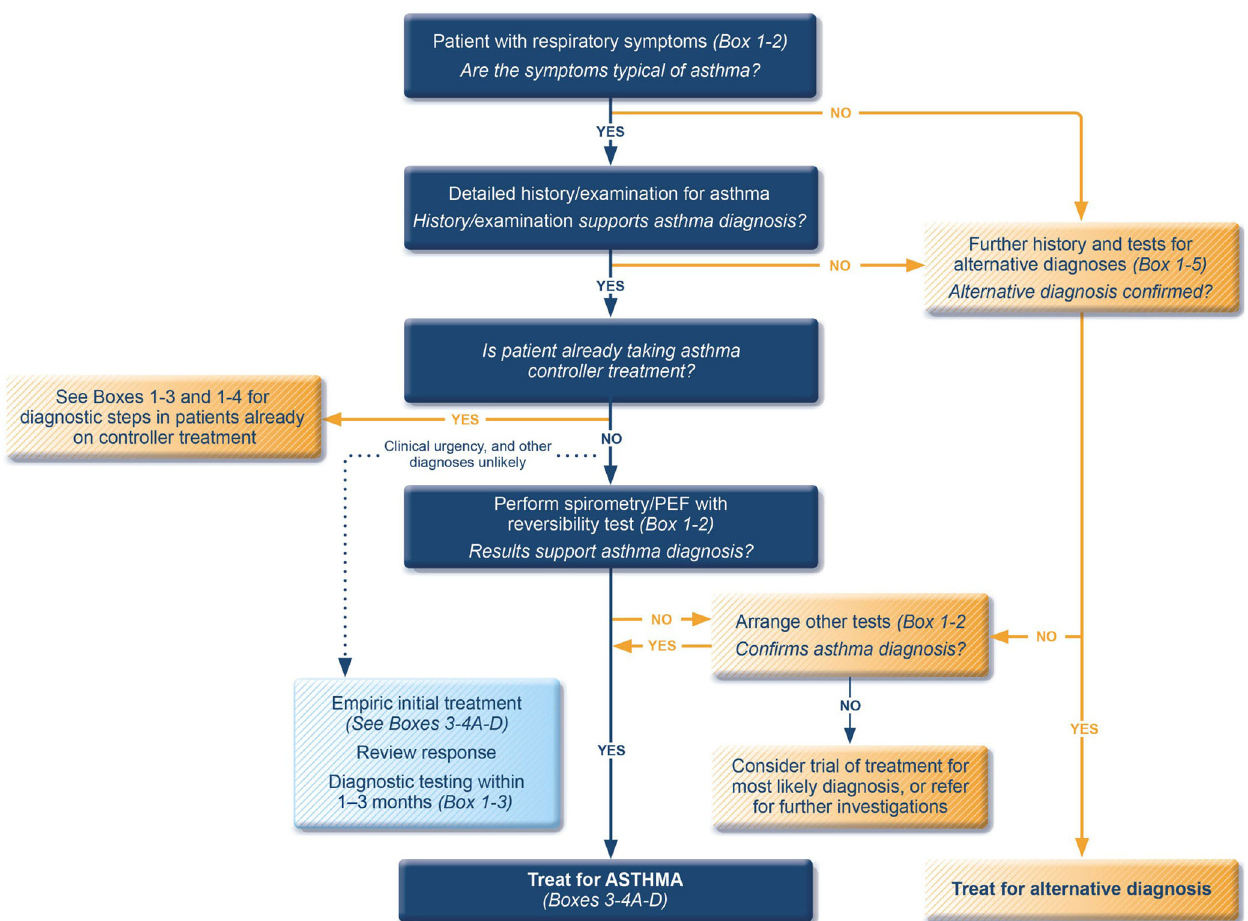
Fig. 1 The GINA diagnostic fl owchart 2022. PEF peak expiratory fl ow. Source: Box 1 – 1 in GINA report 2022. Box numbers within the fi gure refer to the GINA 2022 report. Reproduced with permission from ref. 11